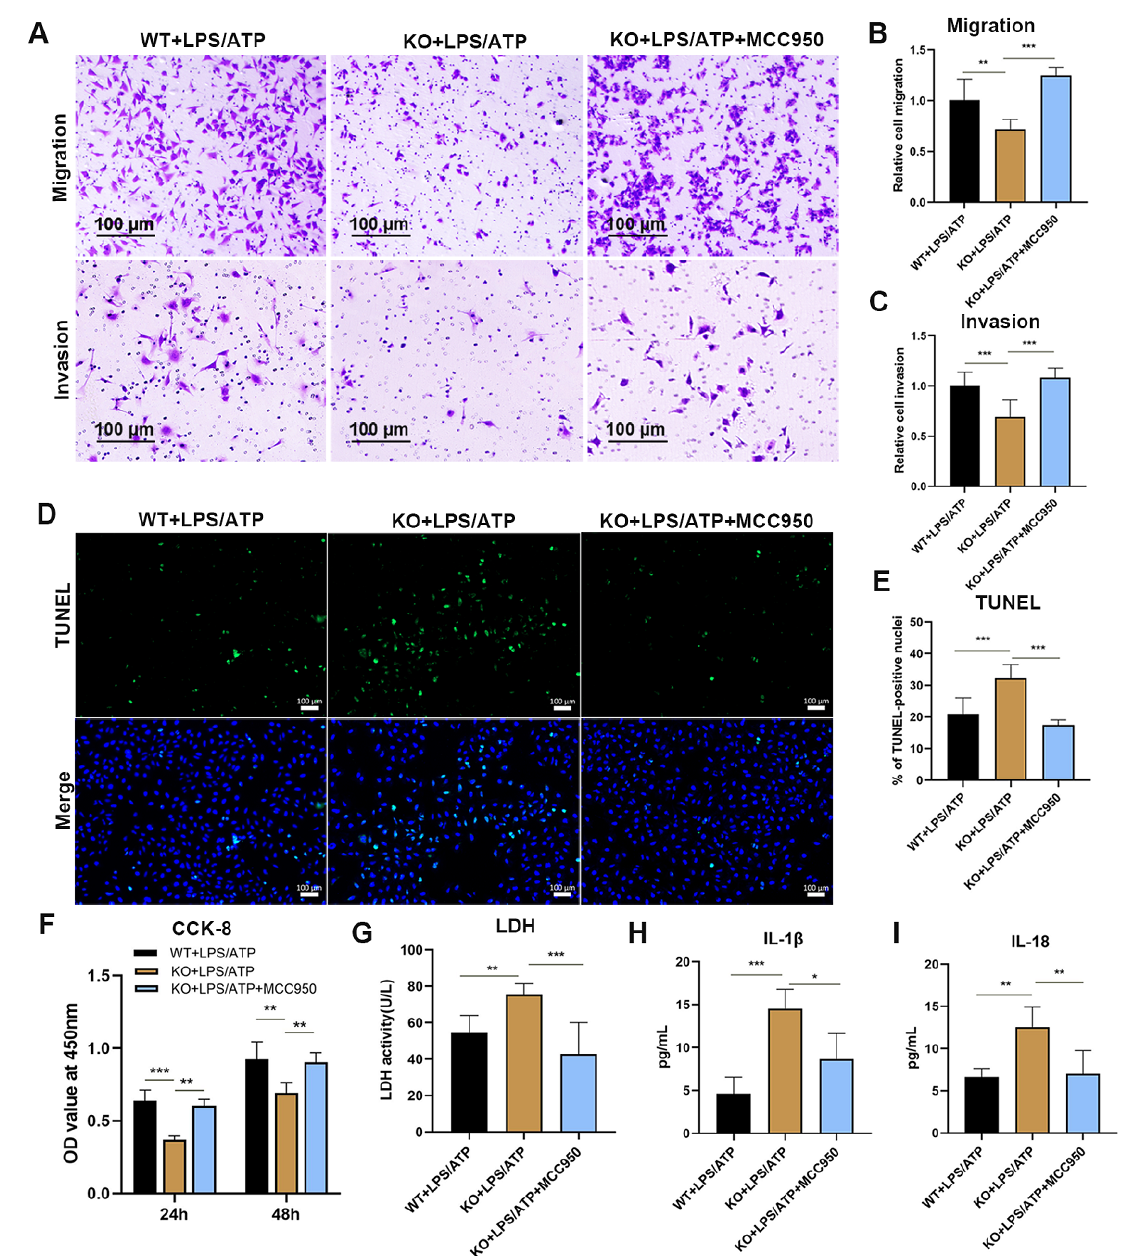
Figure 5. Inhibition of the NLRP3 inflammasome alleviated the inflammatory cascade and pyrop- tosis of TMBIM4 KO HTR8/SVneo cells. ( A – C ) Representative images of transwell migration and